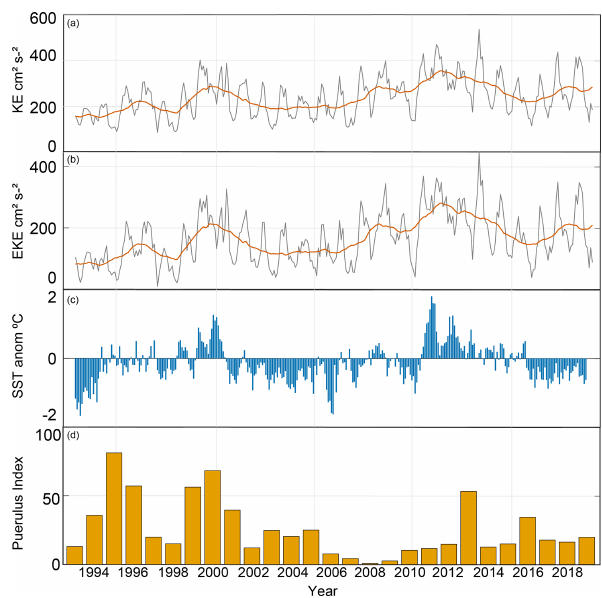
Figure 11. (a) Kinetic energy and (b) eddy kinetic energy (cm 2 s − 2 ) from altimeter data, the (c) SST ( ◦ C) anomaly from SSTAARS, and (d) PI for the whole western rock lobster fishery.